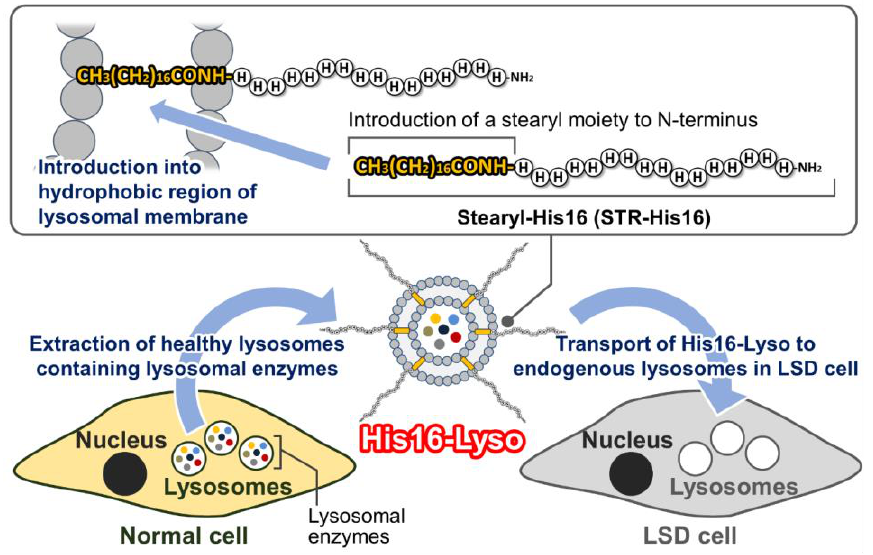
Figure 1. Scheme for organelle replacement therapy (ORT) using His16 peptide-modified lysosomes (His16-Lyso). Healthy lysosomes containing lysosomal enzymes are completely extracted from normal cells. The extracted lysosomes are modified with His16 peptide by insertion of the stearyl-His16 peptide into the hydrophobic region in the lysosomal membrane. His16-Lyso become internalized into LSD cells and are transported to endogenous lysosomes by His16 peptide functions.